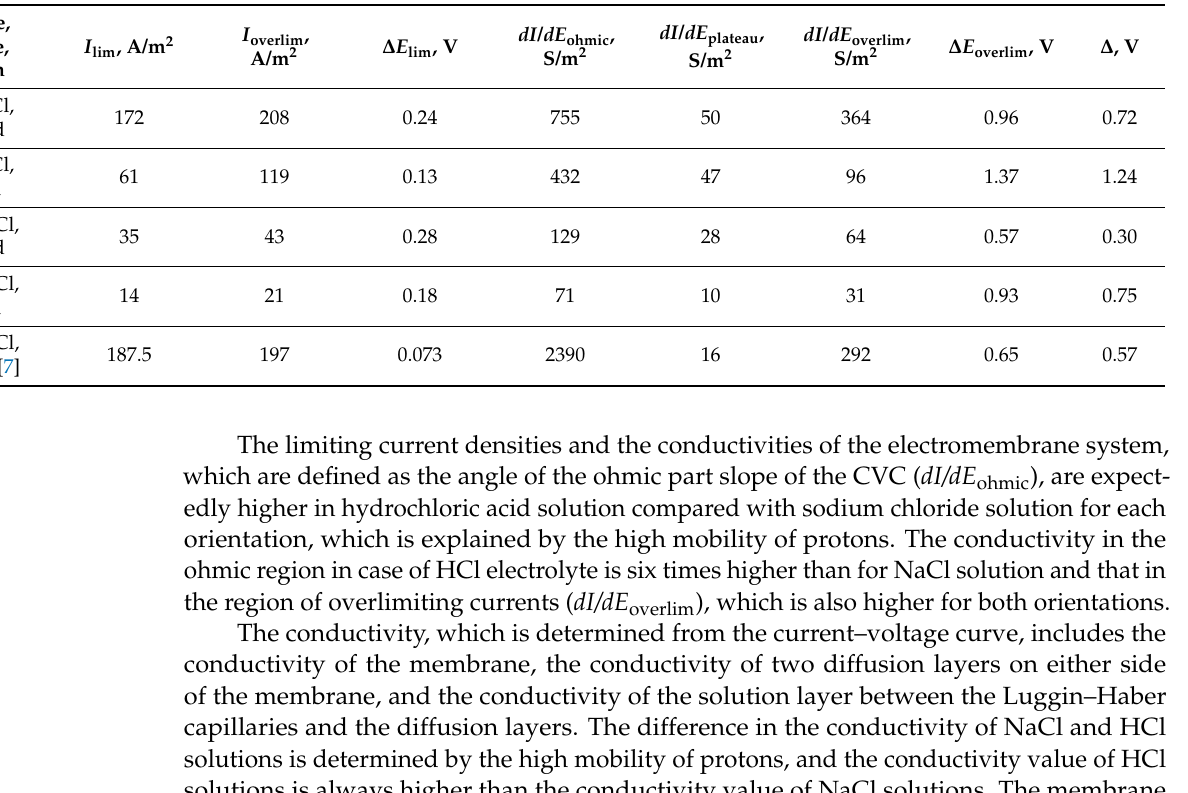
Table 1. The characteristics of the CVCs of the bilayer and pristine